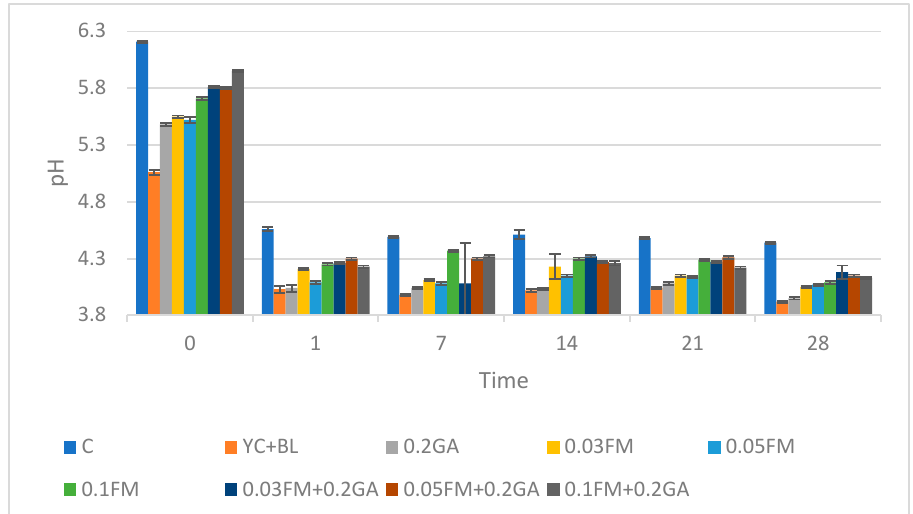
Figure 1. Effect of addition of FM, GA and yogurt culture and B. lactis at different concentrations on pH value in kefir samples. Abbreviations: C, control; YC, yogurt culture; B.L, B. lactis ; GA, gum arabic; FM, flaxseed mucilage.